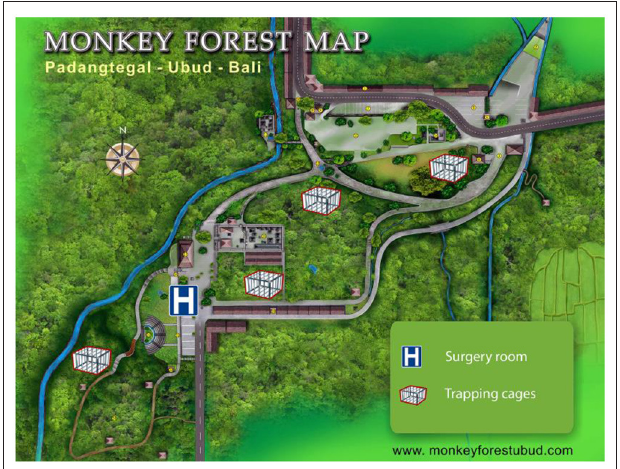
FIGURE 1 | The study site and location of the four trapping cages and the surgery room (modified from